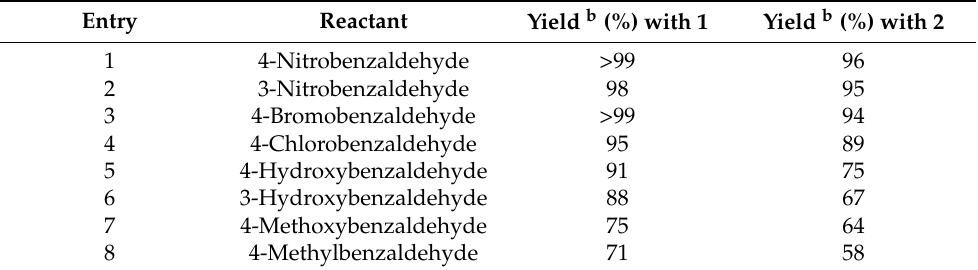
Table 2. Cyanosilylation of different substituted aldehydes with trimethylsilyl cyanide (TMSCN) with catalyst 1 or 2 a . Entry Reactant Yield b (%) with 1 Yield b (%) with 2 4-Nitrobenzaldehyde